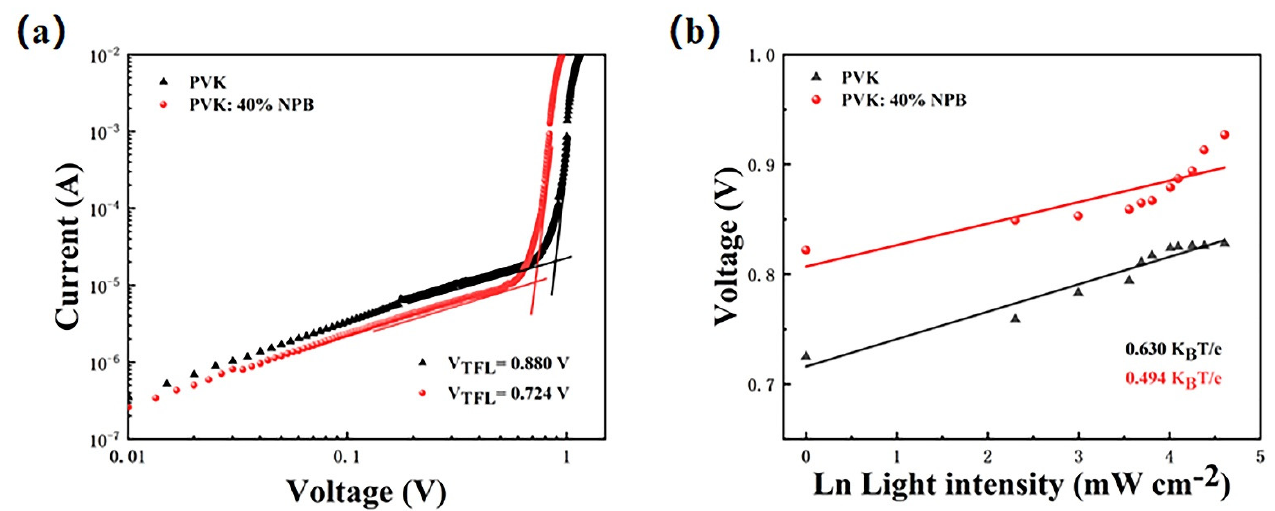
Figure 7. ( a ) Hole-only device based on different HTLs; ( b ) light intensity dependence of V OC . The light intensity increased from 1 to 100 mW cm − 2 .